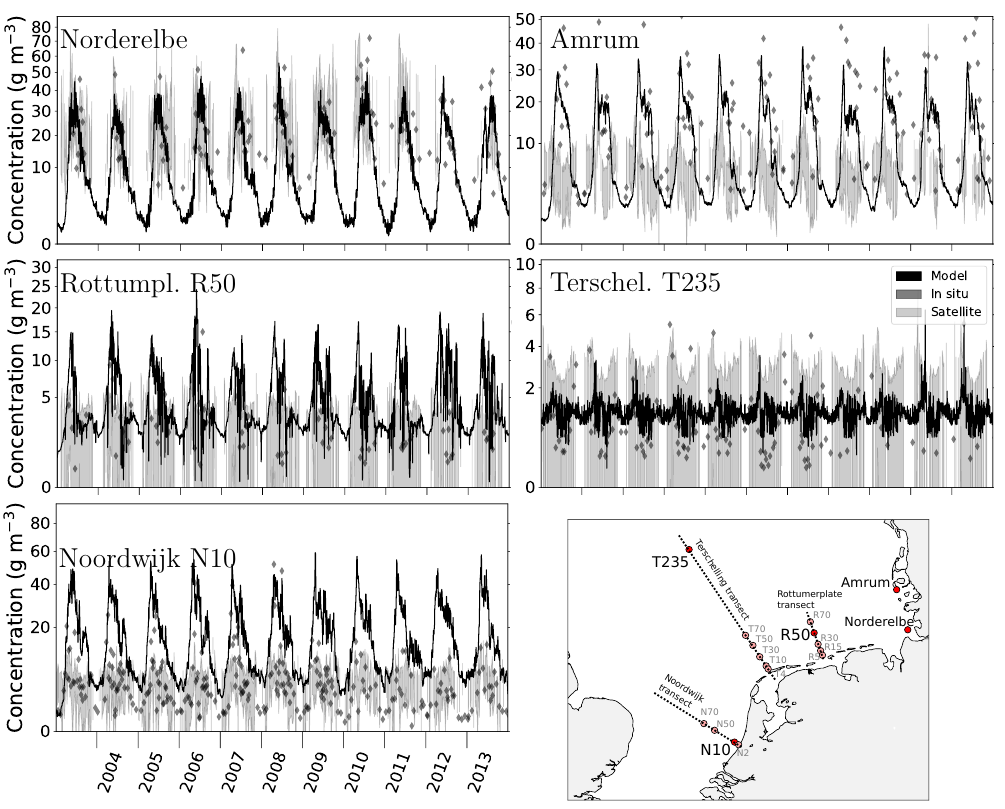
Figure 4. Simulated surface chlorophyll (2003–2013) compared to station data (diamond symbols, Rijkswaterstaat and Federal State of Schleswig Holstein) and satellite observation (shading, European Space Agency Ocean Colour Climate Change Initiative (ESA-CCI) Ocean Colour). Note the different scales on the ordinate axes. The supporting information contains the time series comparison of all stations shown (Figure